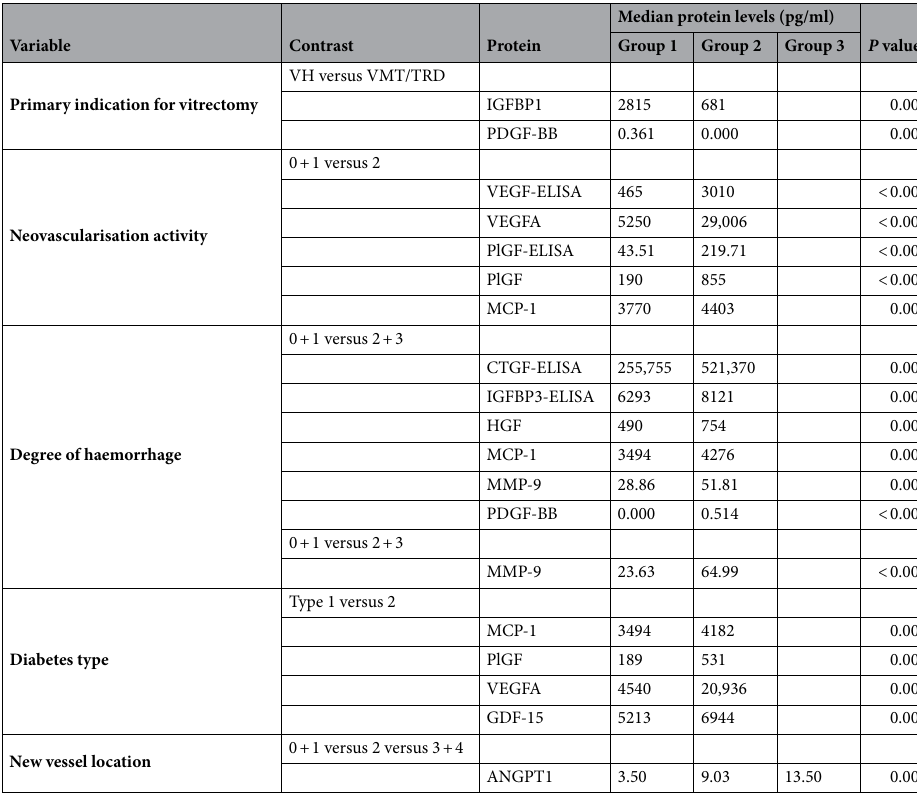
Table 4. Differences in clinical features between defined groups of untreated PDR patients. The null hypothesis that all medians are equal was analysed using the Kruskal–Wallis test. P values represent the significance of differences between group medians. Significant differences ( P < 0.01) are given. Variables are defined in Table 1. VH Vitreal haemorrhage, VMT Vitreo-macular traction, TRD Traction retinal